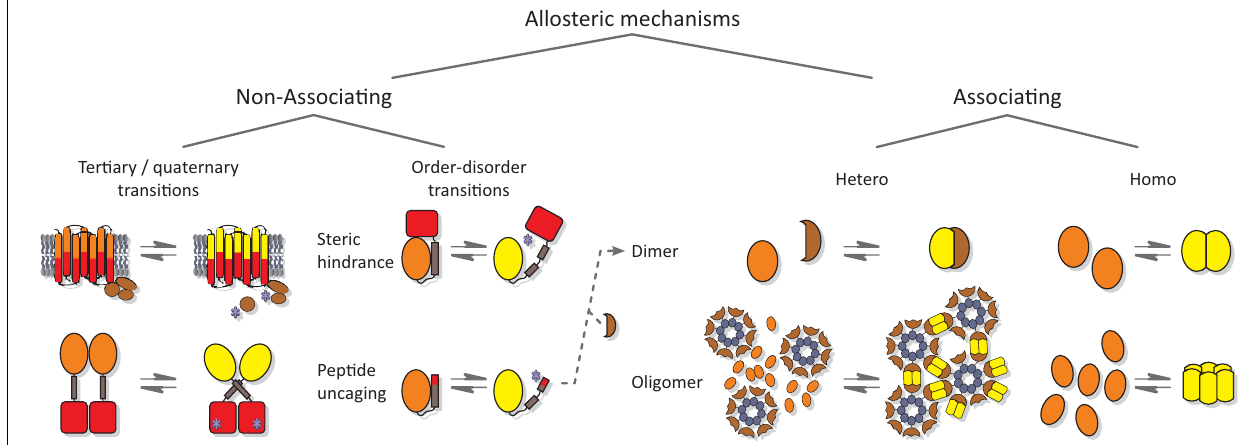
the category of associating photoreceptors (Section Associating Photoreceptors and Optogenetic Applications), light-induced signal transduction goes along with a change in oligomeric state. Association can be either light-promoted or light-repressed; can be between alike (homo) or different (hetero) partners; and can be of dimeric or higher stoichiometry. Note that other categorization schemes are conceivable as well; in particular, several photoreceptors based on light-induced J α unfolding subsequently undergo heteroassociation (Lungu et al., 2012; Strickland et al., 2012; Guntas et al., 2015) (indicated by dashed arrow). Orange and yellow symbols denote T and R states, respectively, of photosensor modules; red symbols denote effector modules; and blue stars indicate effectors in their high-activity